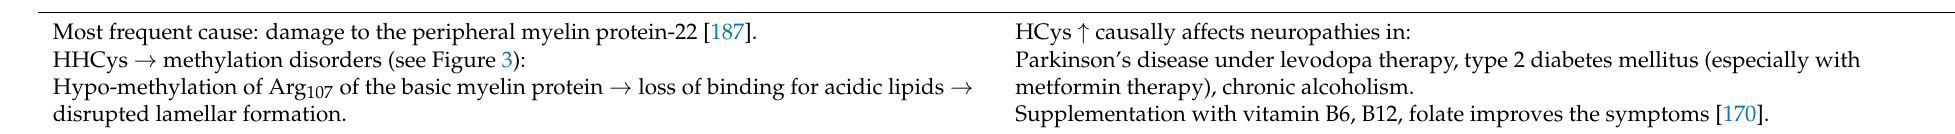
Table A7. Peripheral neuropathy.